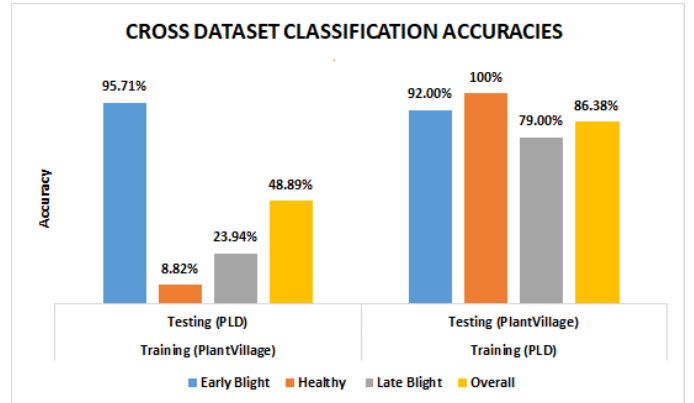
Figure 18. PDDCNN cross dataset classification accuracies.